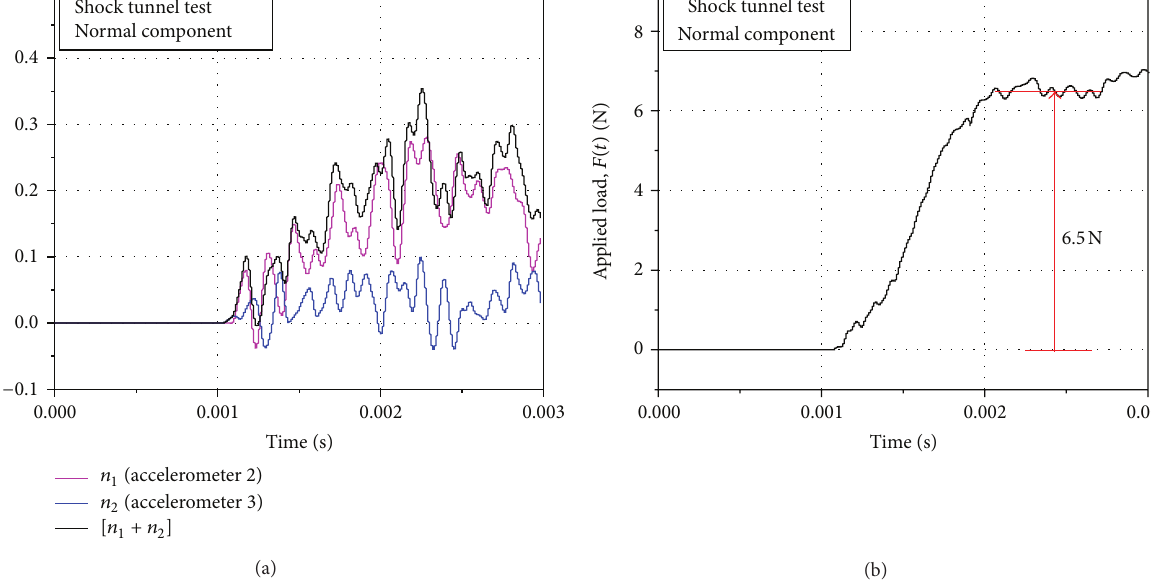
Figure 6: (a) System output and (b) deconvoluted applied load for normal component for aerodynamic test in shock tunnel. Model AOA = 10 ∘